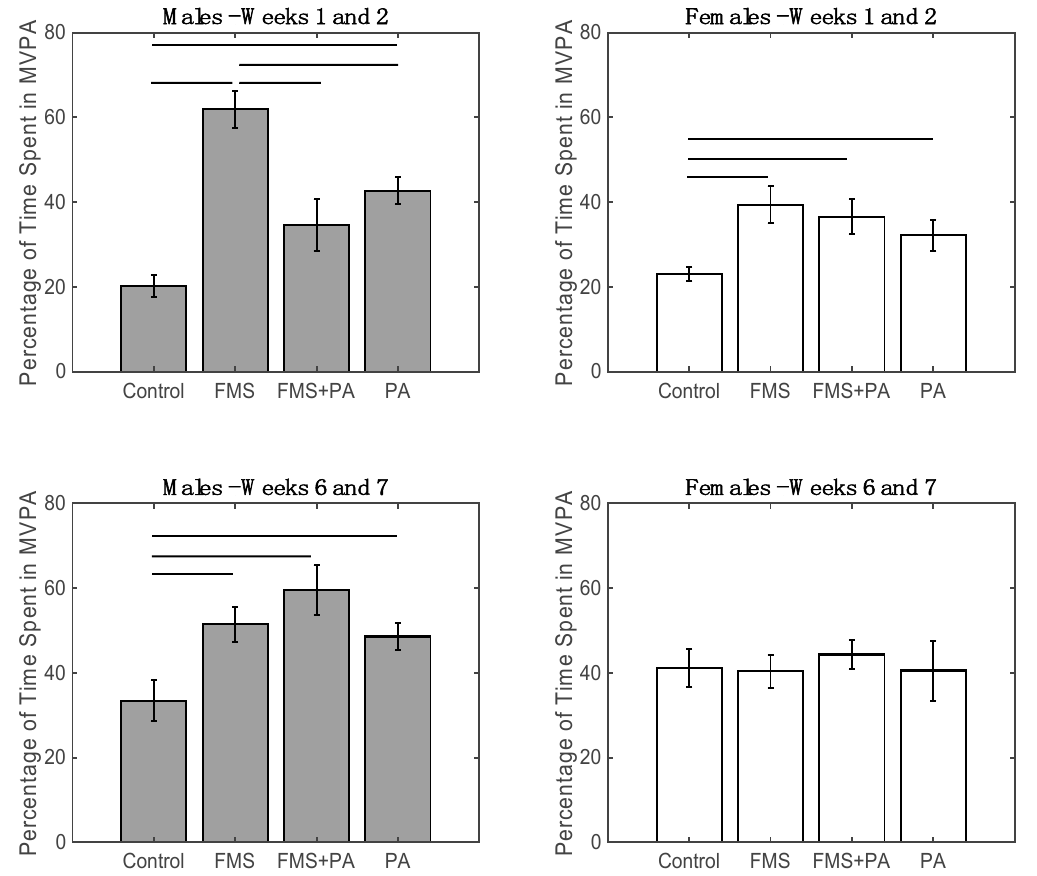
Figure 2. Top: Percentage of time spent in MVPA for weeks 1 and 2 by group (Control, FMS, FMS + PA, and PA) for males (Left) and females (Right). Bottom: percentage of time spent in MVPA for weeks 6 and 7 by group (Control, FMS, FMS + PA, and PA) by for males (Left) and females (Right). Means and standard errors are presented. Lines represent significant t -tests at p < 0.05.